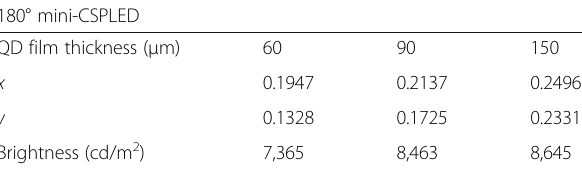
Table 4 The CIE chromaticity coordinates ( x , y ) and brightness for the 180° mini-CSPLEDs with different QD film thicknesses